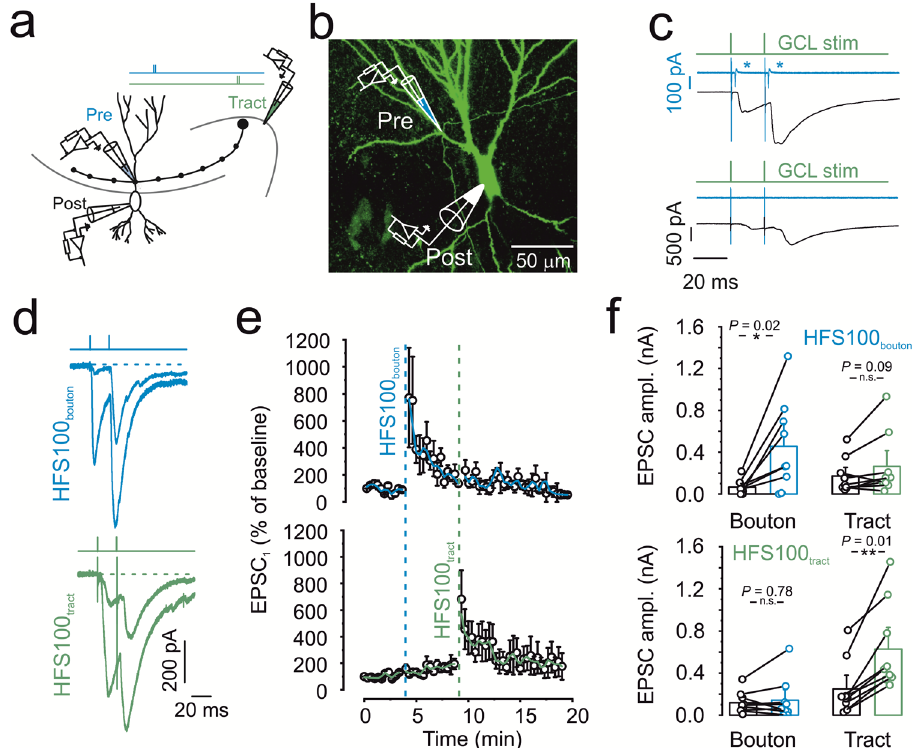
Fig. 1 Speci fi city and non-cooperativity of hippocampal mossy fi ber PTP. a Schematic illustration of experimental setup. EPSCs were evoked by alternating stimulation of presynaptic terminals in the minimally invasive tight-seal bouton-attached con fi guration (blue pipette near proximal apical dendrite) or by tract stimulation (green pipette near granule cell layer). Two pulses were applied with 20 ms interval. b Maximum stack projection of confocal images of a biocytin- fi lled pair, stained with Alexa 488-conjugated streptavidin. Pipette on top indicates the approximate location of the tight-seal cell-attached mossy fi ber bouton (MFB) recording, the pipette at the bottom shows whole-cell CA3 pyramidal cell recording. Representative micrograph; similar results were obtained in 14 biocytin-labeled pairs from a different set of experiments. c Selecting parallel and independent mossy fi ber inputs converging on a single CA3 pyramidal cell. Top, example in which presynaptic action current analysis indicates input overlap. Green trace indicates tract stimulation, blue trace represent currents measured in tight-seal con fi guration at the level of the MFB, and black trace shows EPSCs. The occurrence of action currents at the MFB (indicated by blue asterisks, top panel) indicates stimulation overlap and led to the exclusion of the recordings. Bottom, example in which presynaptic action current analysis indicates input separation. d Representative traces showing EPSCs evoked by bouton stimulation in tight-seal cell-attached mode (top, blue traces) or by mossy fi ber tract stimulation (bottom, green traces). e Normalized EPSC 1 amplitude plotted against experimental time. Blue vertical dashed line indicates delivery of a 1-s HFS 100 at the level of the MFB, held in tight-seal cell-attached mode. Green vertical dashed line indicates delivery of HFS 100 at the level of the mossy fi ber tract. Top graph shows unitary EPSCs evoked by direct MFB stimulation, blue line shows running average from 2 points. Bottom graph shows compound EPSCs evoked by stimulation of the mossy fi ber tract, green line shows running average. f Summary bar graphs showing the EPSC amplitudes derived from direct bouton stimulation (left, “ Bouton ” ) and from mossy fi ber tract stimulation (right, “ Tract ” ). Effect of bouton (top panel) or tract (bottom panel) HFS 100 as indicated. Boxes represent mean values, and circles show individual measurements. A paired non-parametric two-sided Wilcoxon signed rank test was used to test for statistical signi fi cance. * indicates P < 0.05, ** represents P < 0.01, and n.s. denotes non-signi fi cant difference ( P ≥ 0.05). Data in e and f are from 9 pairs. Error bars indicate PTP against the number of APs and the coef fi cient of variation of physiological induction paradigm, we performed a series of affects the fi rst three EPSCs (Fig. 2c, f), we used the average PTP value (PTP 1 – 3 ) for quanti fi cation. Correlation analysis revealed spike freely (Fig. 2g). The number of postsynaptic APs observed during presynaptic HFS 100 was 8.7 ± 1.5 on average (ranging between 4 and 14), and also in this setting PTP (174.2 ± 23.7%; 292.8 ± 76.5 pA in control versus 506.2 ± 120 pA after HFS 100 ; 12 pairs) was signi fi cantly reduced as compared to control experi- ments performed in previous work with postsynaptic voltage- clamp (432.5 ± 73.9%; 173.7 ± 37.8 pA in control and 612.9 ± 87.9 pA after HFS 100 ; 12 pairs; P = 0.0002; Fig. 2g) 10 . The magnitude of PTP was slightly larger than that in the presynaptic HFS 100 + postsynaptic HFS 100 experiments, but the difference did not reach statistical signi fi cance (0.1 mM EGTA post ; P = 0.067; Fig. 2g). Thus, few postsynaptic spikes, not locked in time to presynaptic spikes, were suf fi cient to inhibit PTP. To further characterize the effects of postsynaptic fi ring on PTP, we plotted the magnitude of